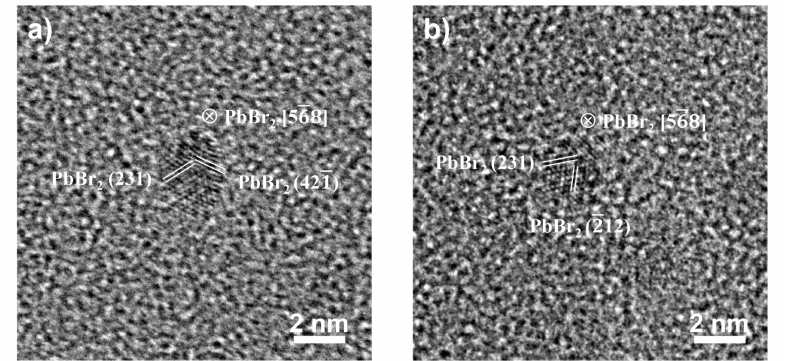
Figure 8. High-resolution TEM images of the PbBr 2 NPs found on carbon films along a [568]